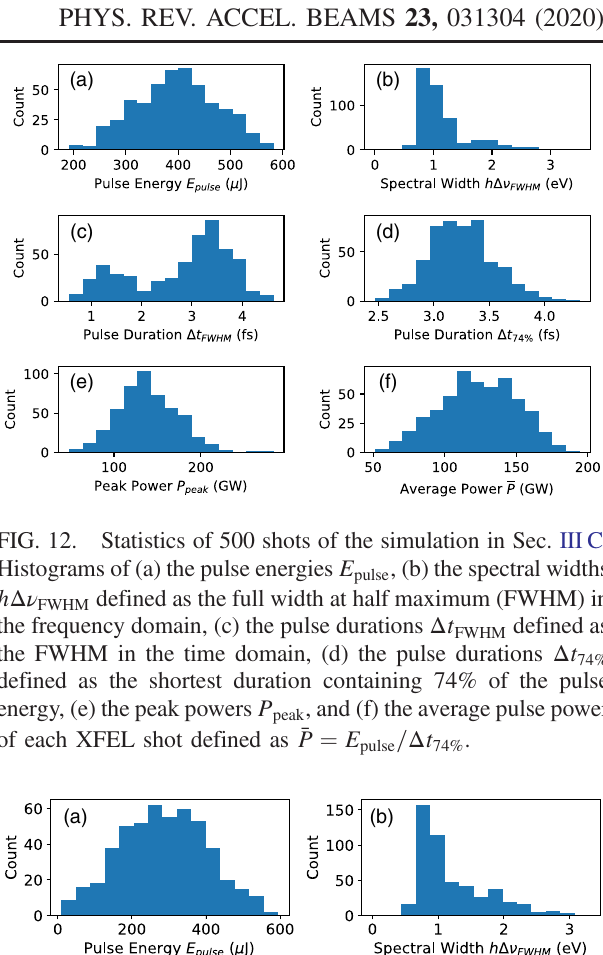
and the pulse , FWHM